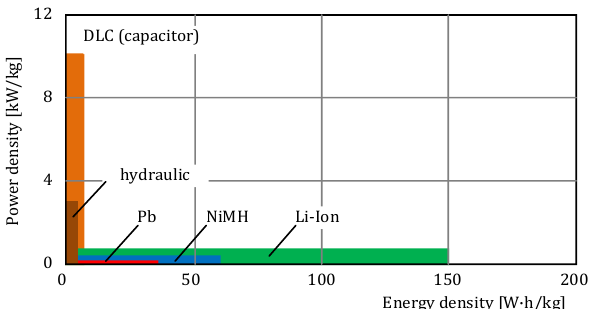
Fig. 4. Comparison of power and energy density of available batteries